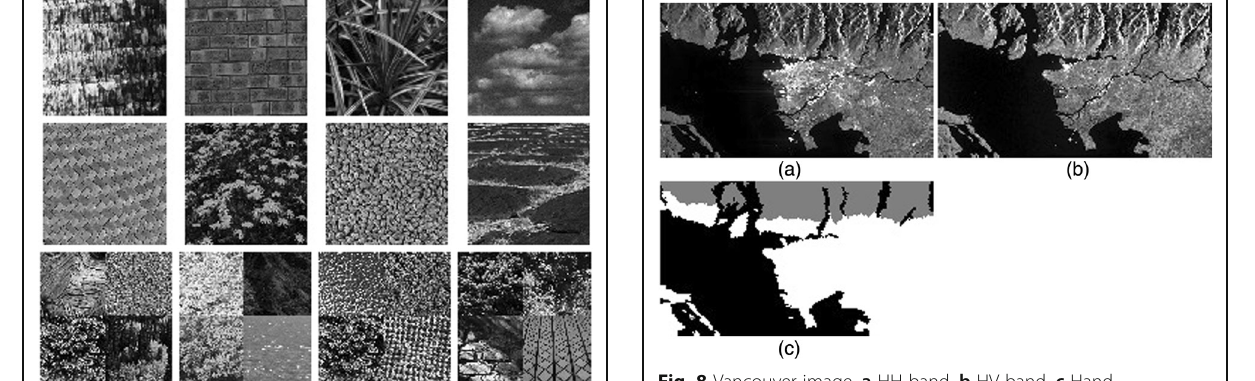
Fig. 8 Vancouver image. a HH band. b HV band. c Hand segmented